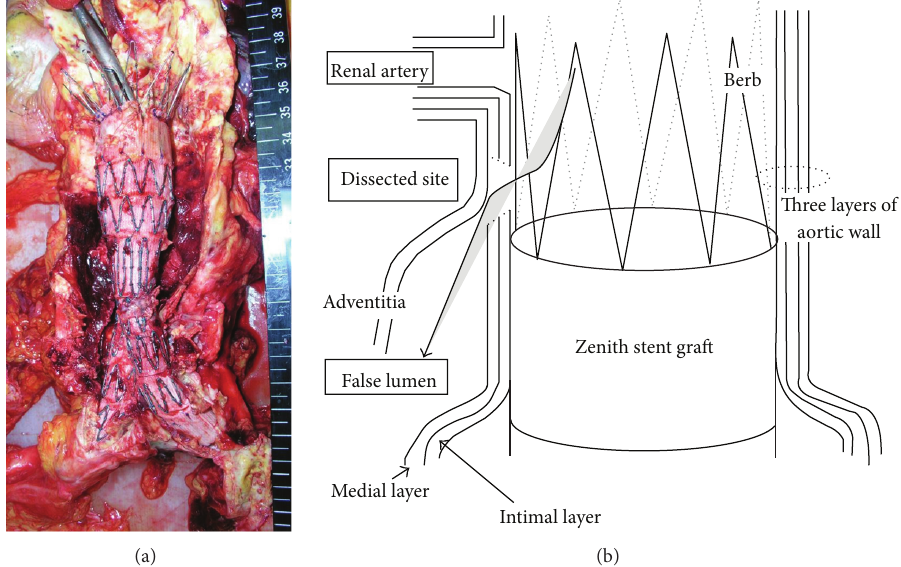
Figure 1: (a) Image of the stent graft after the aneurysmal wall was opened. The stent graft was firmly fixed on the native aortic wall at both the proximal and distal necks. (b) A schema representing the aortic dissection. The dissected site was located just below the right renal artery and the proximal region of the stent graft edge. The device material was fixed firmly to the native aorta.